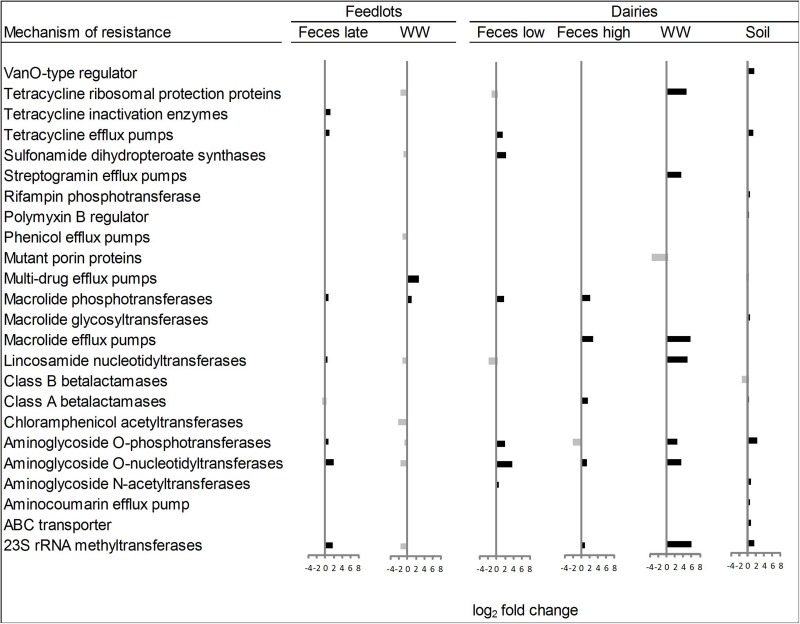
Mechanisms of resistance more abundant (P < 0.05) in conventional (right bars, black) or in “raised without antibiotic” farms (left bars, gray), for types of sample that showed significant (P < 0.05) non-metric multidimensional scaling (NMDS) separation in ordination plots (Feces late, feces collected from feedlot cattle late in feeding period; Feces low, feces collected from low producing dairy cows; Feces high, feces collected from high producing dairy cows, and WW, wastewater).